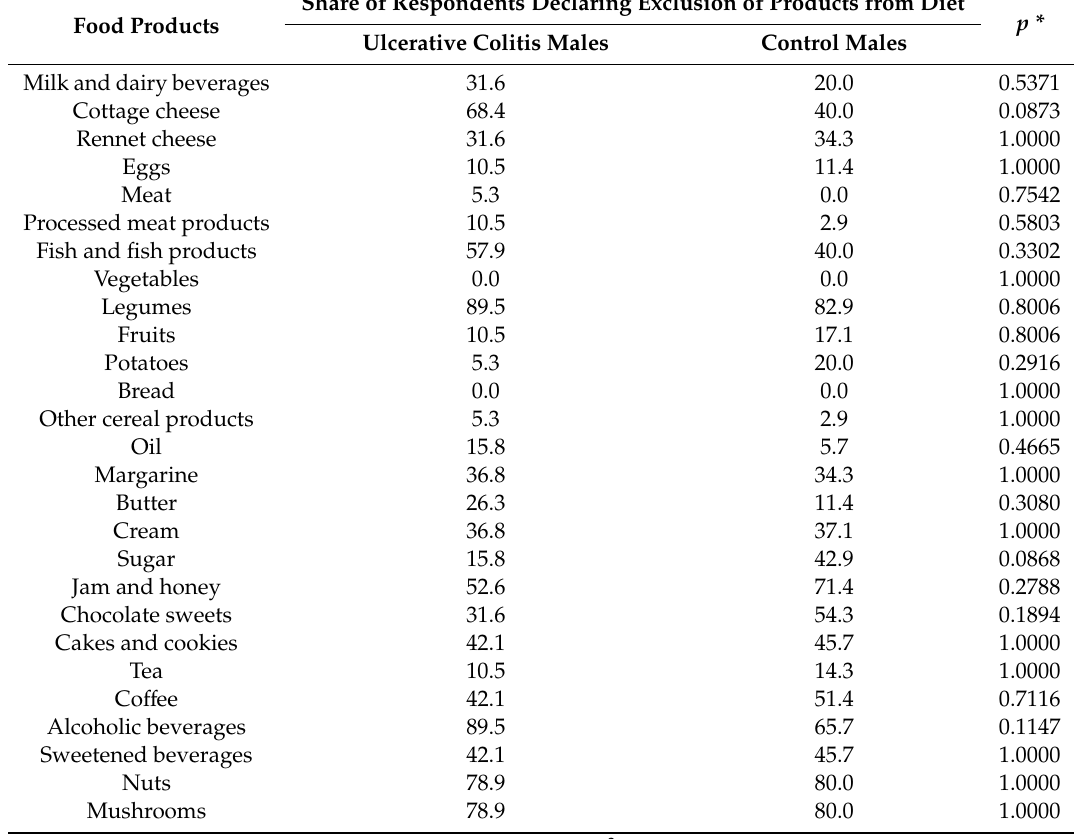
Table 9. The food products declared as excluded from diet in ulcerative colitis males and control